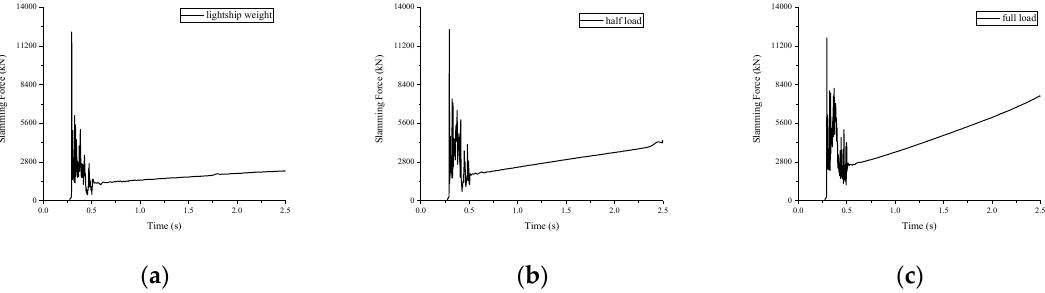
Figure 15. Comparison of the velocity of the parallel middle body among three loading conditions.